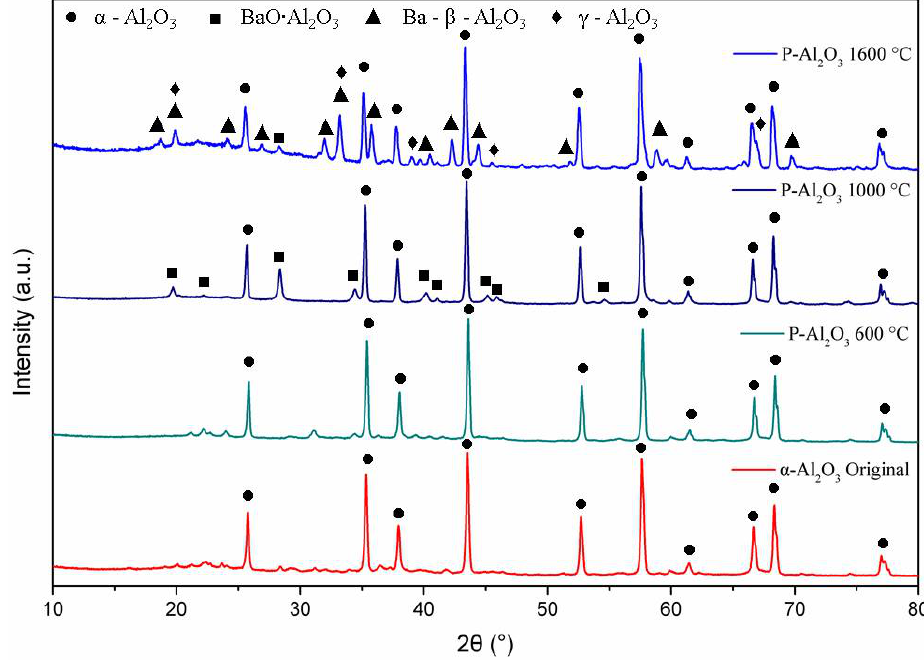
Figure 4. DRX of the alumina powders and sphere treated at different temperatures.